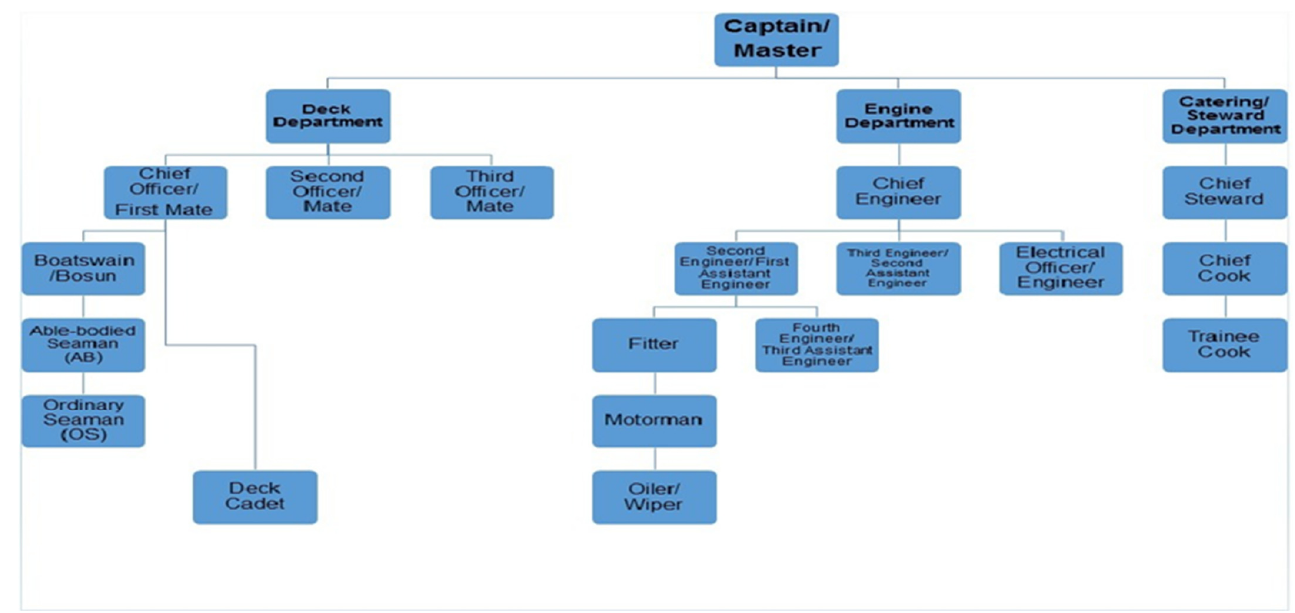
Figure 1. Work locations (Source: own study).